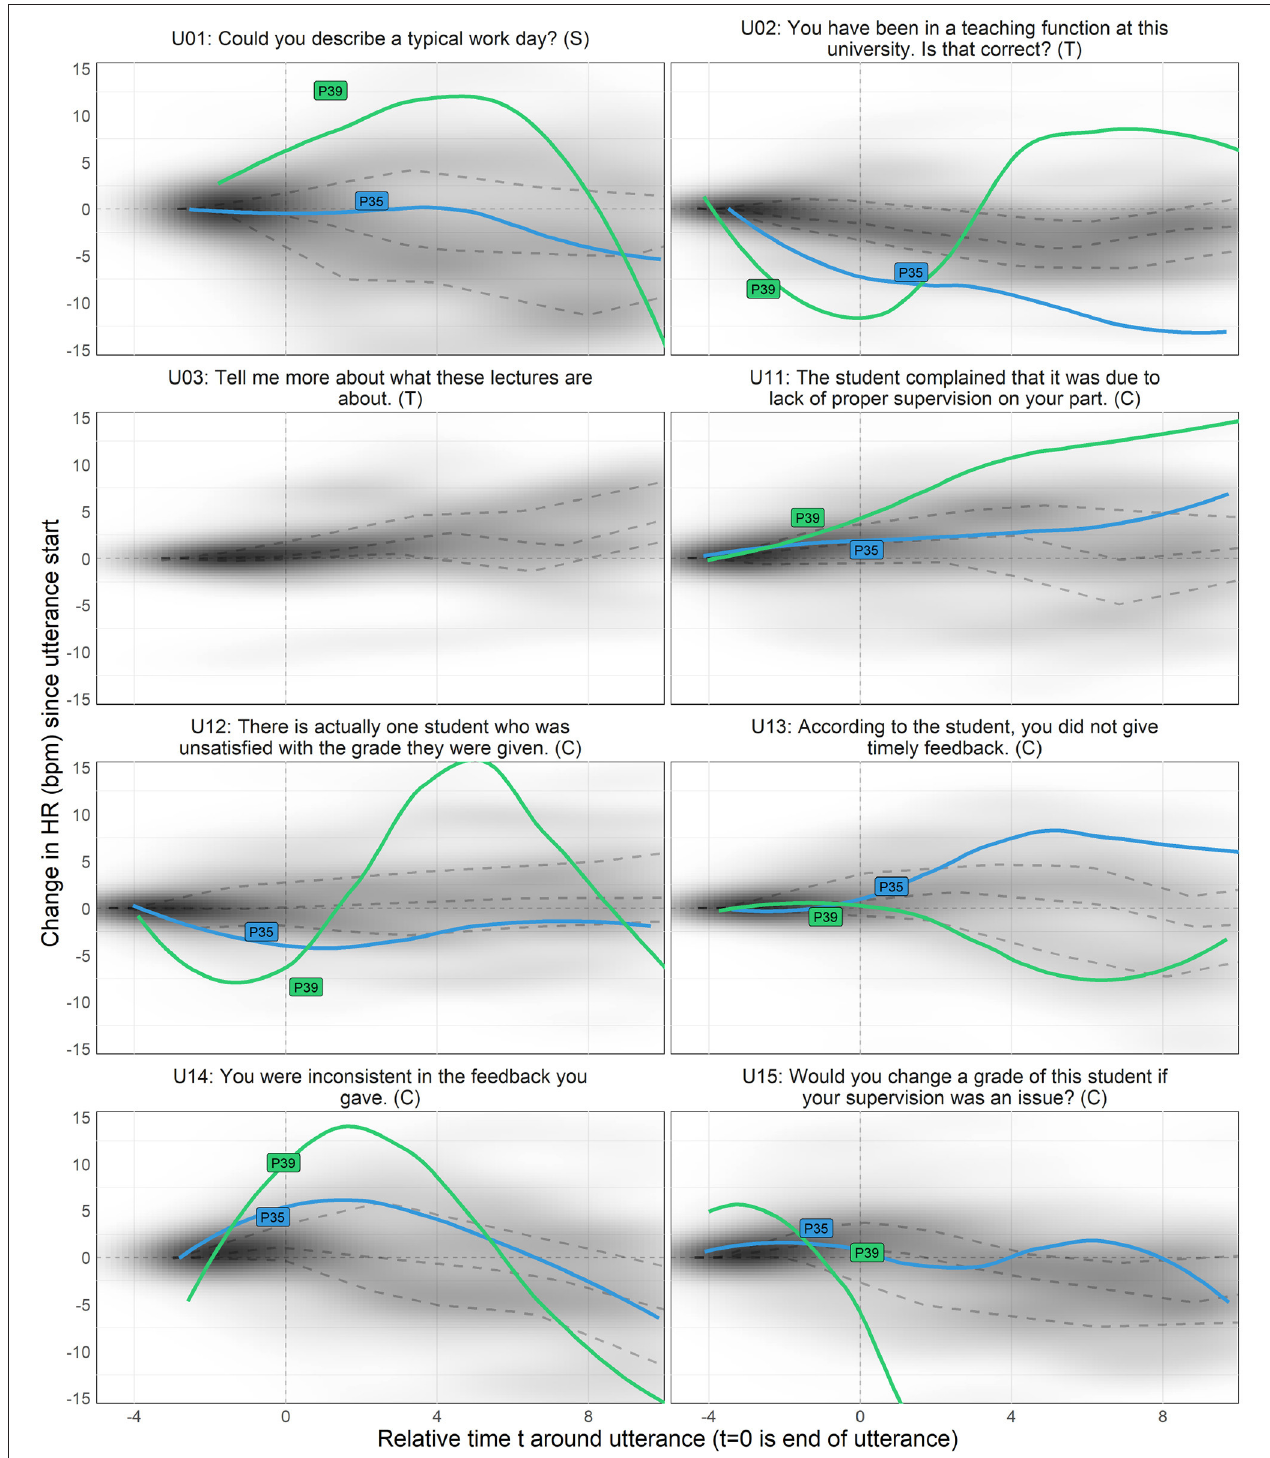
FIGURE 2 | Density of changes in HR after hearing agent utterances over time, in seconds, per utterance. Utterance end-times are aligned at x = 0. Quantile regression lines are shown as gray dashed lines, at 75, 50, and 25% from top to bottom (RQSS method, Koenker, 2019). For illustrative purposes, trajectories of two individually examined participants are